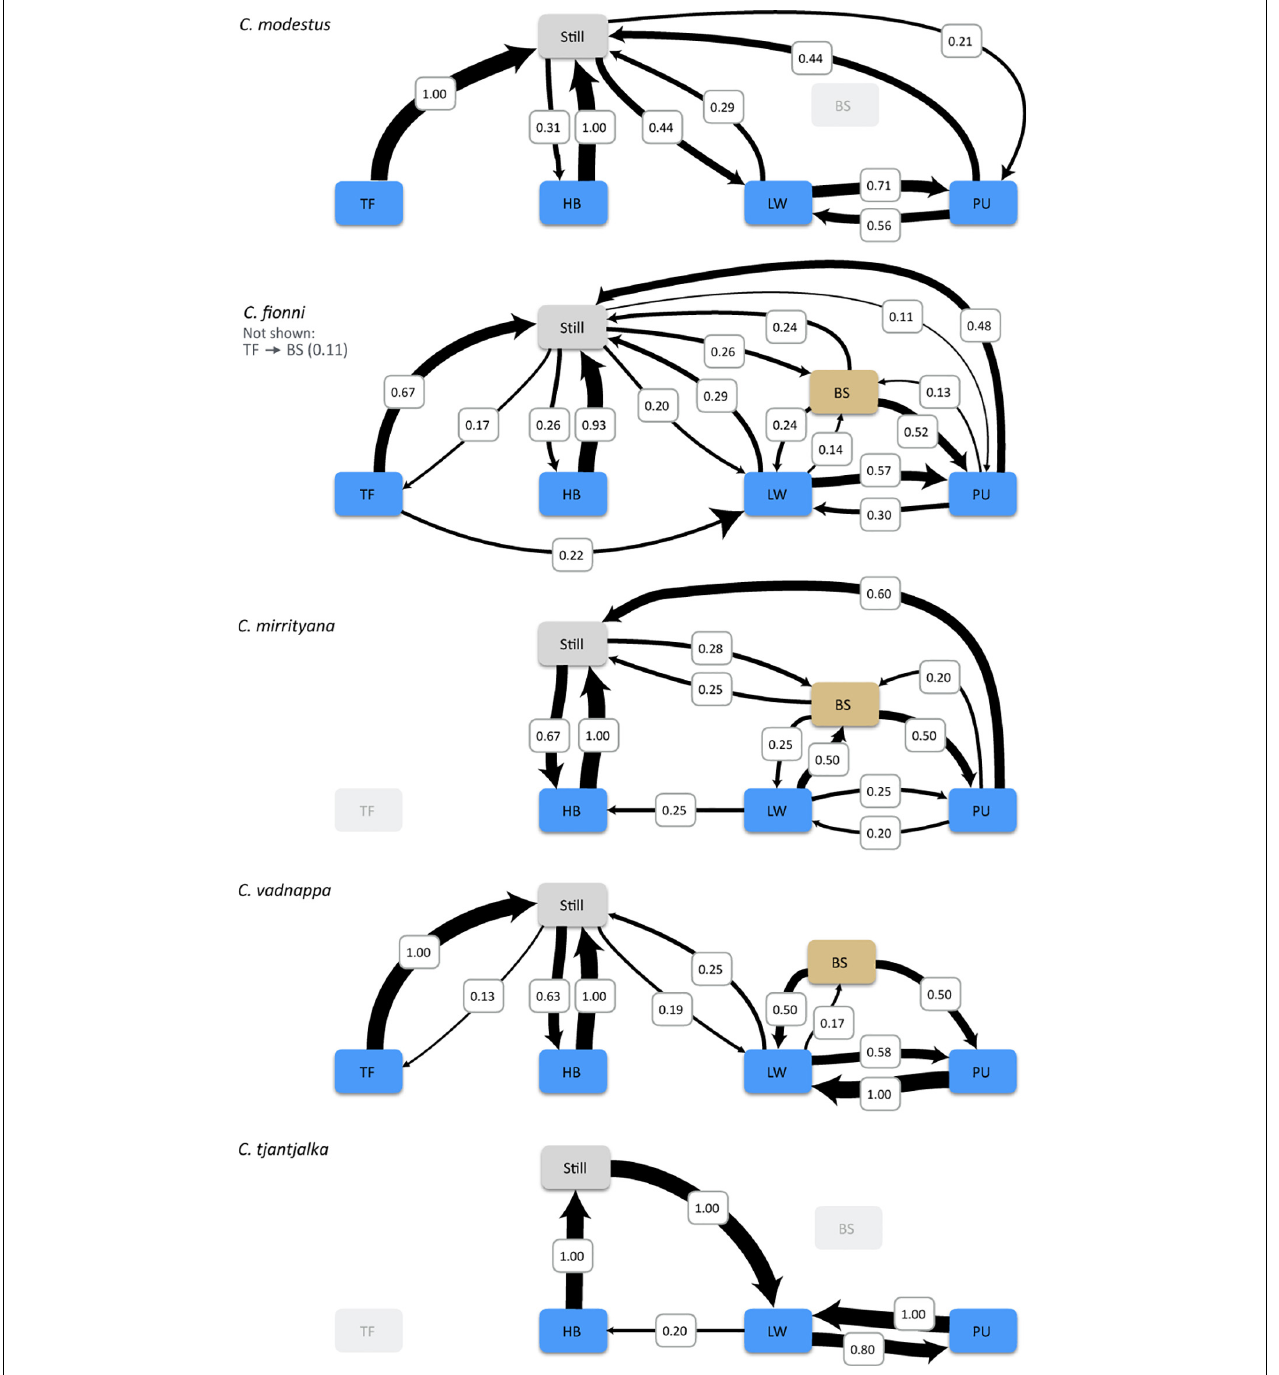
FIGURE 3 | Transition probabilities belonging to the territorial displays of the five study species. The plots illustrate the sequence in which motor patterns (HB, head bob; LW, limb wave; PU, push up; TF, tail flick) and body switch (BS; change in position) are used during the display and the probability that one motor pattern will occur after another. All sequences start from a still position. Tail flicking is known to occur in C. mirrityana but was not observed during the analyses.